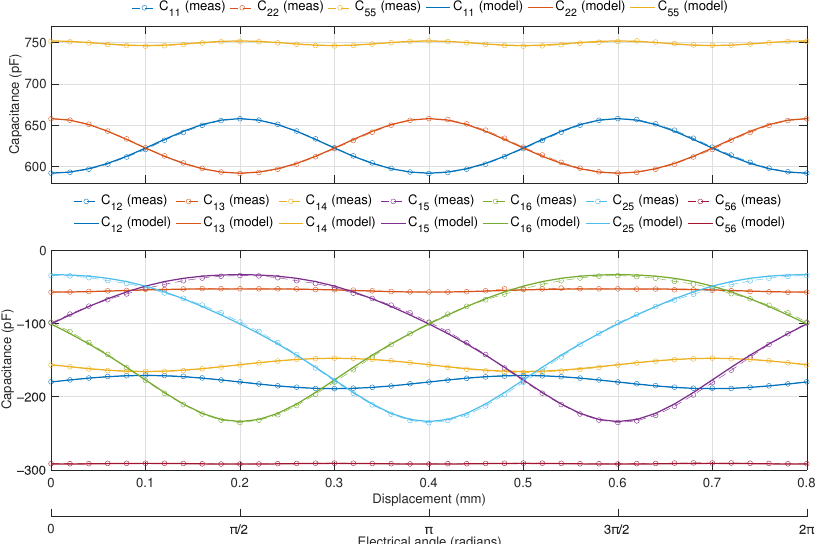
Figure 2. Capacitance versus displacement, for different elements of the capacitance matrix (indices indicate position within the